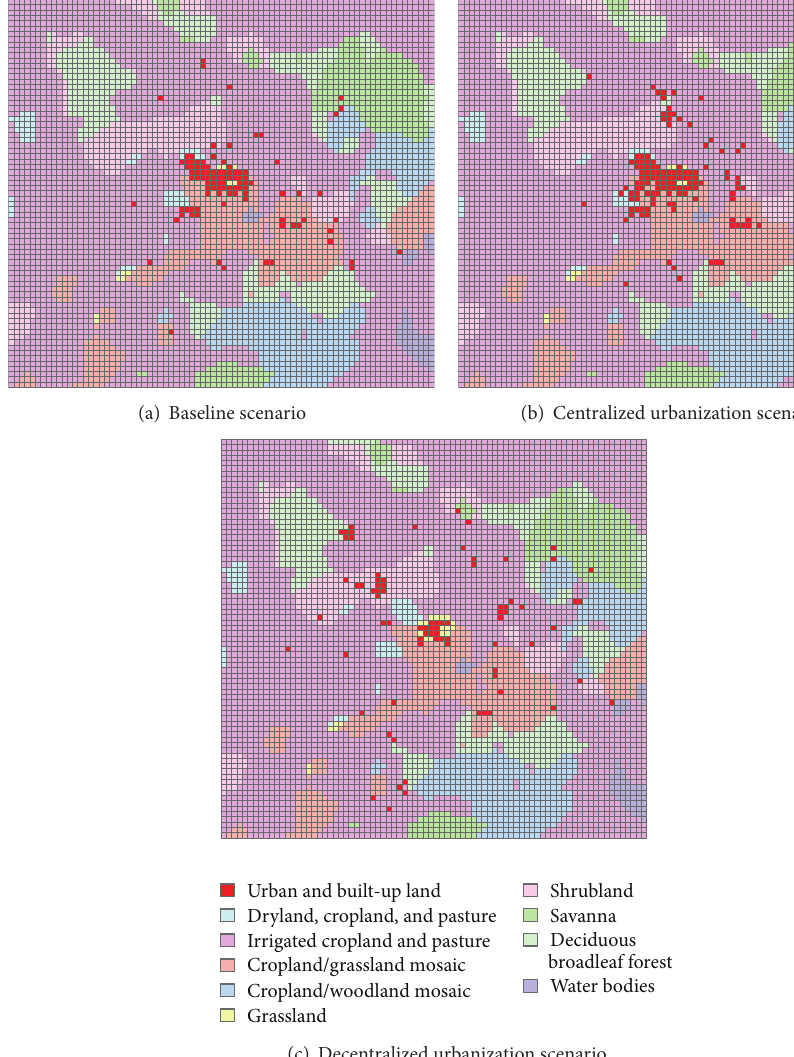
Figure 4: Underlying surface data of Wuhan Metropolitan under different scenarios.